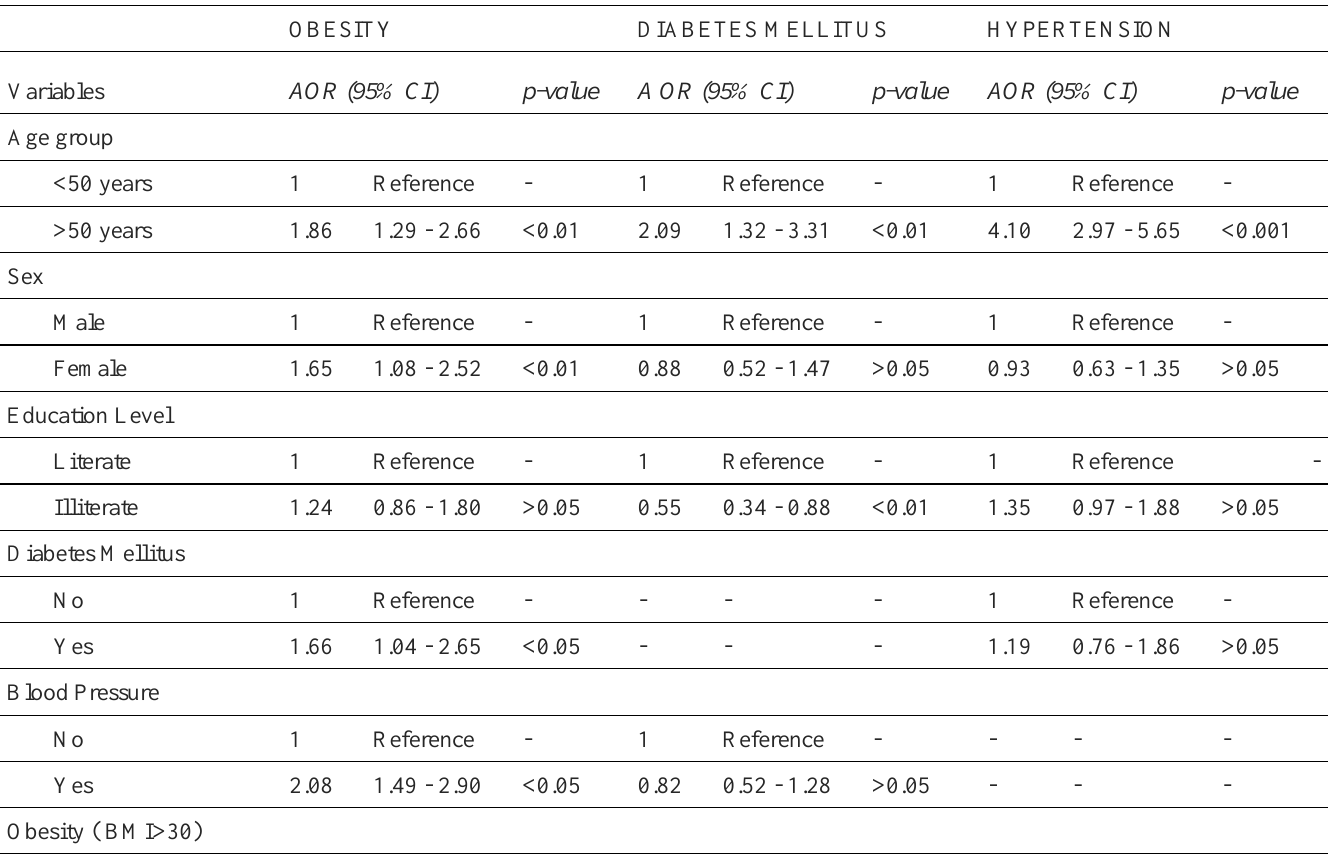
Table 4: Multivariate analysis risk factors associated with obesity, hypertension, and diabetes mellitus. OBESITY DIABETES